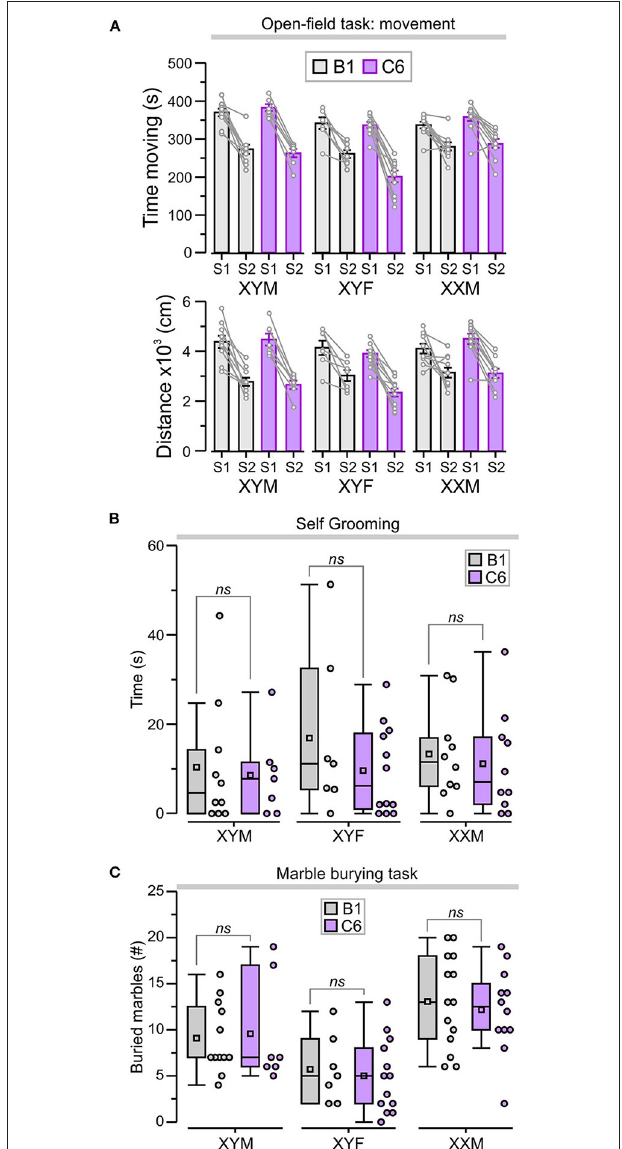
FIGURE 4 | C6 exposure in utero did not lead to an increase in repetitive behaviors. (A) Top , graph shows the total time (mean ± SEM) moving during sessions 1 and 2 (S1 and S2). Bottom , total distance traveled (mean ± SEM) as a measure of locomotor activity in the open-field task. The lines linking each S1 and S2 represent the scores for individual animals. (B) Box-and-whisker plots for cumulative time self-grooming show median and Q1–Q3 quartiles (whiskers are 10–90 range). Dots represent individual animals. C6-exposed mice did not exhibit increased self-grooming compared to B1 control groups, irrespective of genotype. (C) Box-and-whisker plots show the number of marbles buried (more than 50% of the surface area covered by bedding) during the marble-burying task. The number of marbles buried was not significantly different between B1- and C6-exposed mice, irrespective of genotype; 2-way ANOVA with Tukey test was used for statistical comparisons. See Table 1 and Supplementary Table 2 for details of statistical testing; ns =